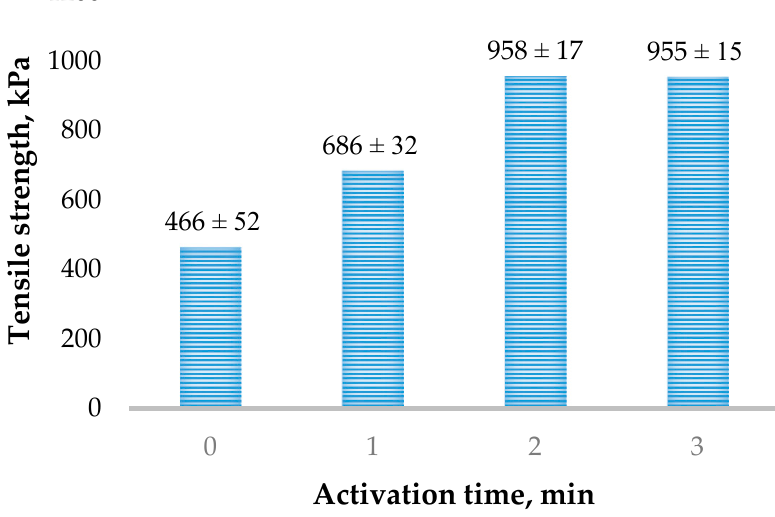
Figure 3. Tensile strength of the sapropel activated for different durations.